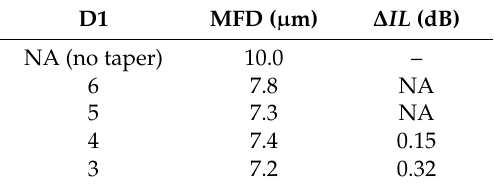
Table 1. MFD as the function of D1 and the addition loss introduced by the tapered